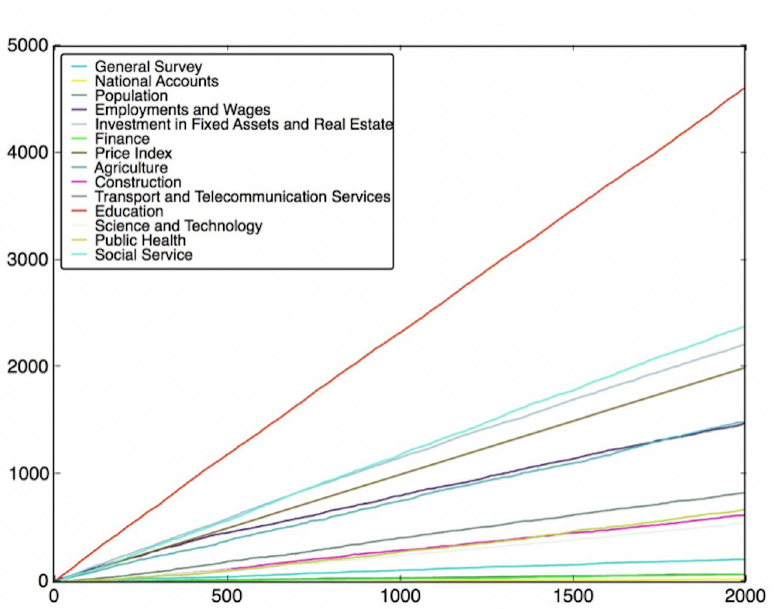
Fig 13. SVR with 10 features and clustering